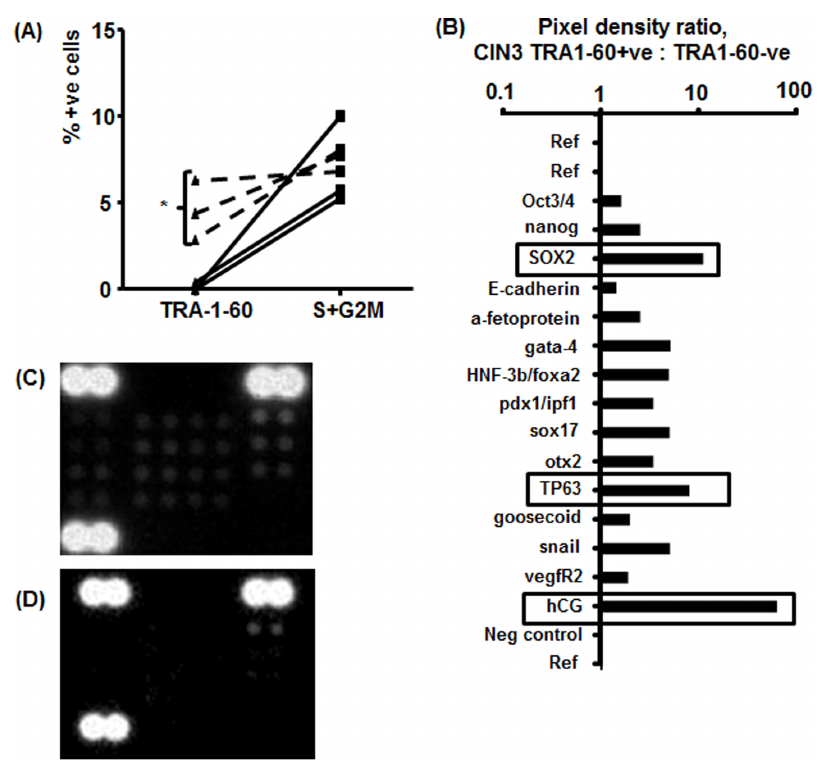
Fig. 5. Samples with increased TRA-1-60 + ve cells from patients with CIN3 have enhanced expression of stem cell proteins. A) Flow cytometric analysis of samples used for proteomic microarray. Dotted lines show that the three samples with a significant increase in TRA-1-60 + ve cells have similar levels of cycling cells to the other three CIN3 samples. * 5 p , .05. B) Image-J pixel density analysis of stem cell proteomic microarray. SOX2, TP63 and HCG are further increased in samples with increased TRA-1-60 + ve cells. C) Inverted image of the scan of the array from TRA1-60 + ve samples; D) Inverted image of the scan of the array from TRA1-60 –ve